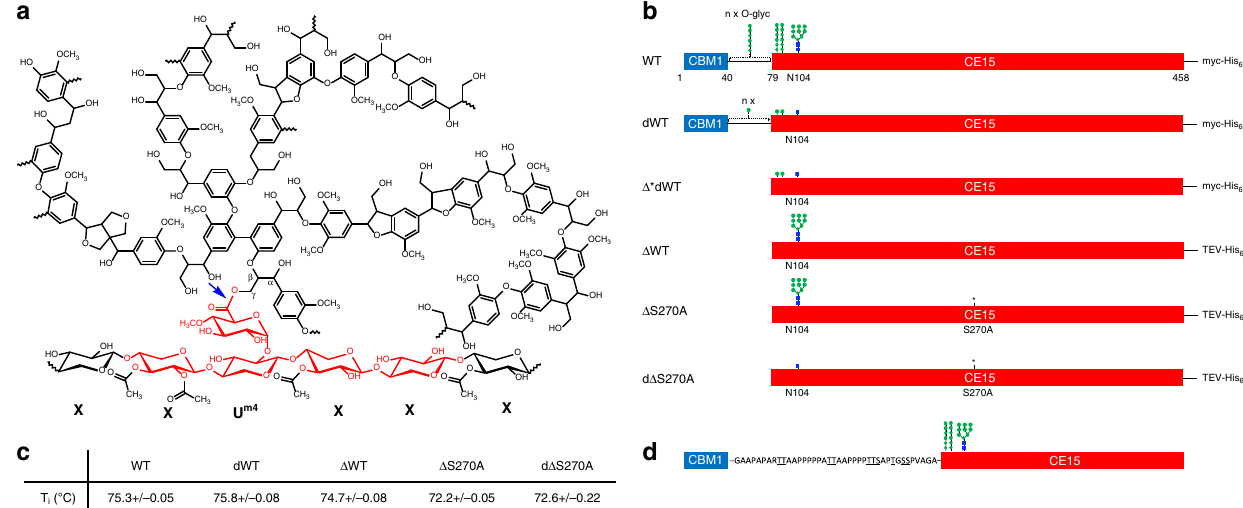
Fig. 1 Proposed natural LCC substrate and Cu GE variants. a Structural representation of a natural LCC substrate for glucuronoyl esterases. The ester- linked LCC (blue arrow) connects two polymeric structures; acetylated glucuronoxylan substituted with α -1,2-linked 4- O -methyl-glucuronoyl moieties and lignin. The 4- O -methyl-glucuronoyls form ester bonds with γ -alcohols from lignin. The carbohydrate structure corresponding to the three different ligands in the Cu GE crystallographic complexes are marked in red. Each xylosyl unit is named X and the 4- O -methyl-glucuronoyl substituted xylosyl is named U m4 . b Cu GE variants used in this study. The full-length enzyme (WT) has a modular structure with a CBM1 domain appended to the catalytic CE15 domain via a linker. Positions that are post translationally modi fi ed in the recombinant enzyme with either N- or O-glycosylation are stylized (NAG blue squares; MAN green dots). Here, only the core structure of the glycans is shown, but especially the N-glycosylation is quite extensive and heterogeneous in the recombinant enzyme produced in Pichia pastoris . “ Δ ” symbolizes a truncated variant without the CBM1 and linker region. In the inactive Δ S270A variant the catalytic nucleophile S270 has been changed to an alanine. “ d ” denotes variants that have been enzymatically deglycosylated. Notably, the cleaved variant Δ *dWT was spontaneously produced in crystallization experiments with dWT. c Relative stability of the Cu GE variants. T i is the apparent thermal unfolding temperature derived from changes in intrinsic fl uorescence and stated with standard deviations. d Sequence of the proline-rich linker region in Cu GE. Potential O-glycosylation sites (S or T) are underlined. Source data for panel c are provided as a Source Data fi